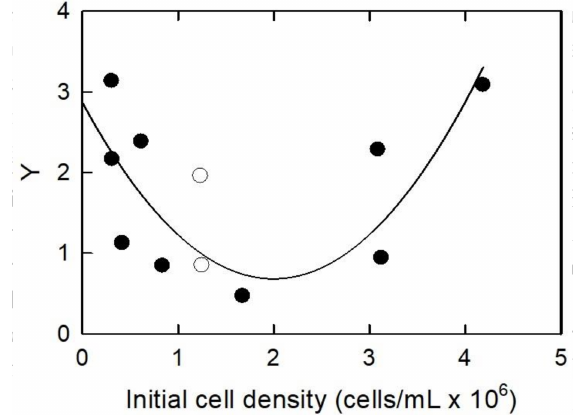
Figure 4. Normalized specific chlorophyll a plotted against the initial cell density. Closed symbols are data points. Open symbols are data that were considered outliers. Values of outliers are 11 × plotted value. Line is fitted using the empirical Equation (8).